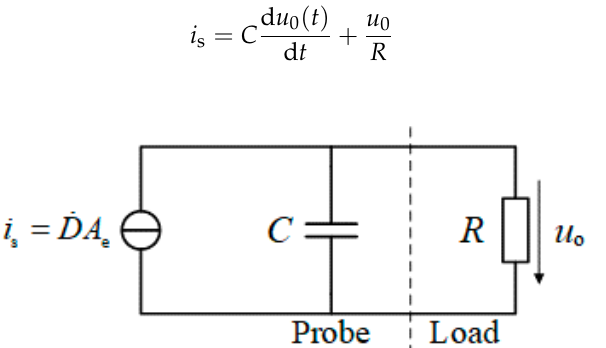
Figure 1. Norton Equivalent circuit of D-dot sensor. Where D refers to the electric flux density of the measured electric field; C refers to the equivalent capacitance of the D-dot sensor; R refers to the characteristic impedance of the transmission line; u 0 refers to the output voltage of the D-dot sensor; A e refers to the equivalent area of probe antenna.